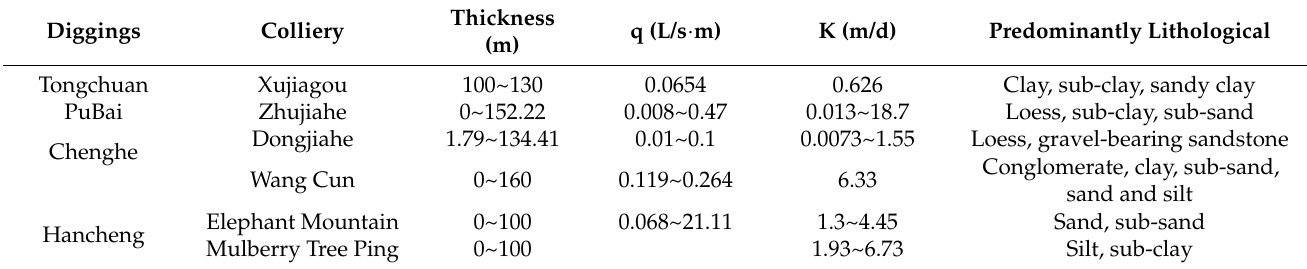
Table 1. Hydrogeological characteristics of quaternary loose rock aquifers.